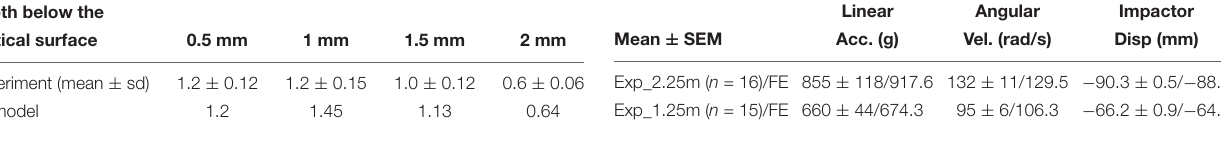
TABLE 4 | Brain-skull relative displacement in the brain: experimental and FE model results. Depth below the